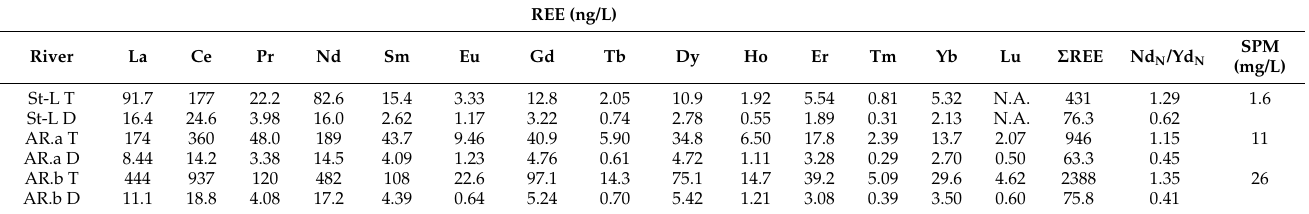
Table 2. Concentrations of lanthanides and suspended particle matter (SPM) in waters of natural rivers, St. Lawrence River (St-L) and Athabasca River (AR), total (T) and dissolved (D) and the ratio Nd N /Yd N . REE